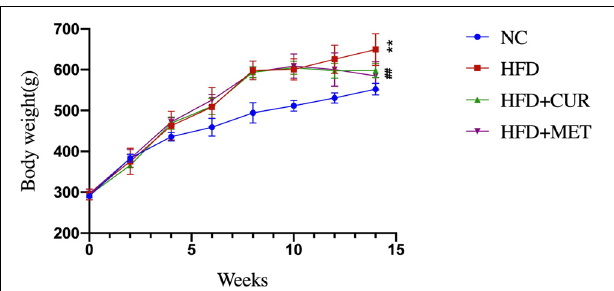
FIGURE 1 | Effects of CUR and MET on body weight. Seven rats per group ( n = 7). Values were presented as the means ± SD for each group. * p < 0.05, ** p < 0.01 compared with the NC group. # p < 0.05, ## p < 0.01 compared with the HFD group.